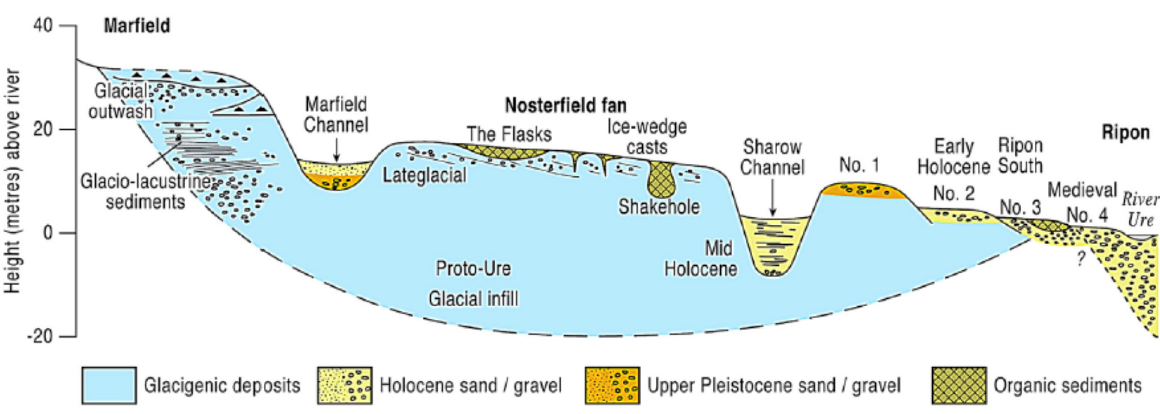
Figure 11. Schematic cross-section through the terrace sequences in the Ure valley, and the stratigraphic position of sites mentioned in this paper and shown in Figure 1. Note that the illustration of the infilled pre-glacial Proto-Ure valley is schematic. This pre-glacial channel was mapped by the Geological Survey and noted by Howard et al. [84] at their Ripon Racecourse site, which was an earlier version of our ‘Ripon South’, the latter located c. 0.5 km further to the SE and not overlying the buried valley, which does not follow exactly the same course as the modern river.